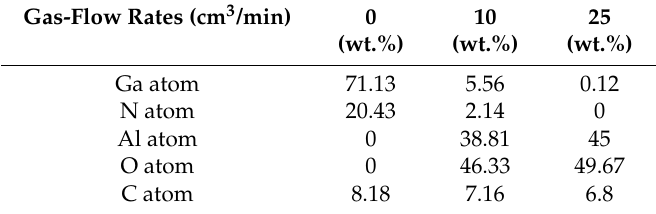
Table 1. Compositions of the GaN-epi/PSSs under different gas flow rates, obtained by EDS. Gas-Flow Rates (cm 3 /min)